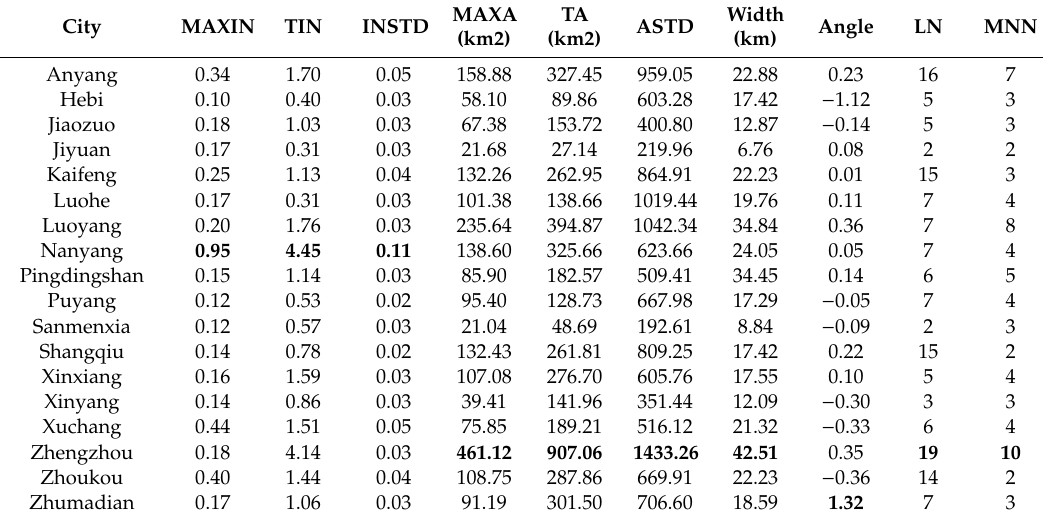
Table 3. City parameters of Henan Province, and the maximum values per column are shown in bold